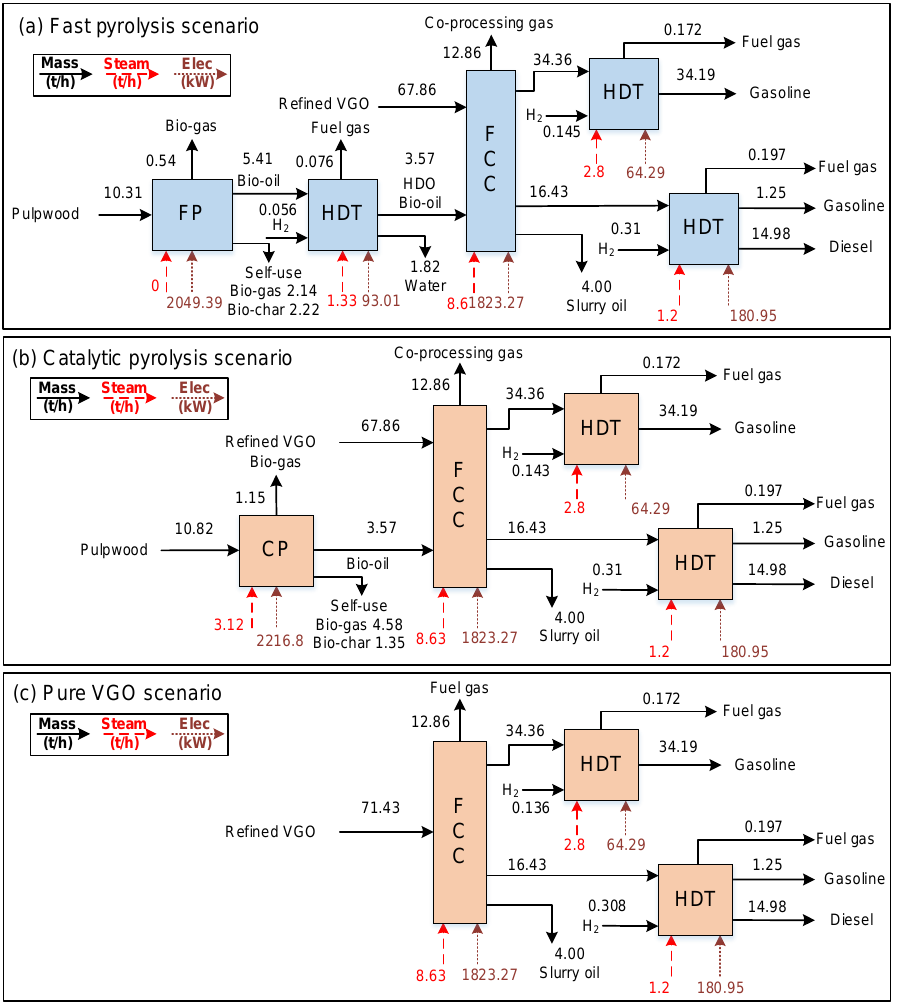
Figure 5. Main mass and energy balances of the three scenarios in Case 2.